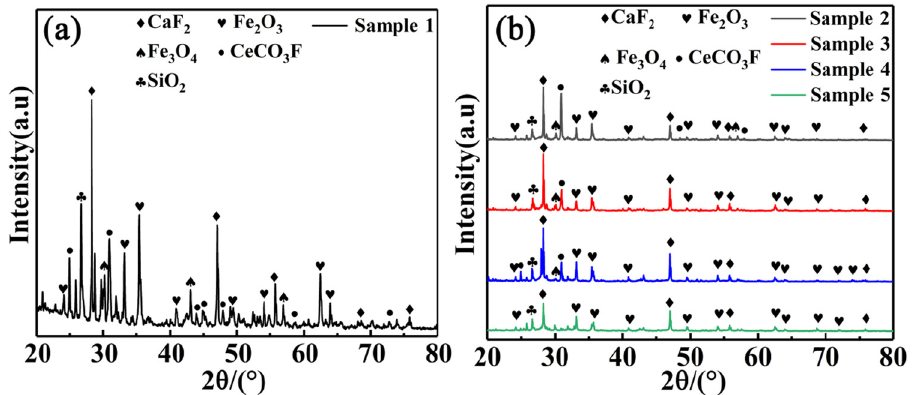
Figure 5: XRD patterns of REE - rich tailings: ( a ) original mine tailings and ( b ) mine tailings calcined at di ff erent